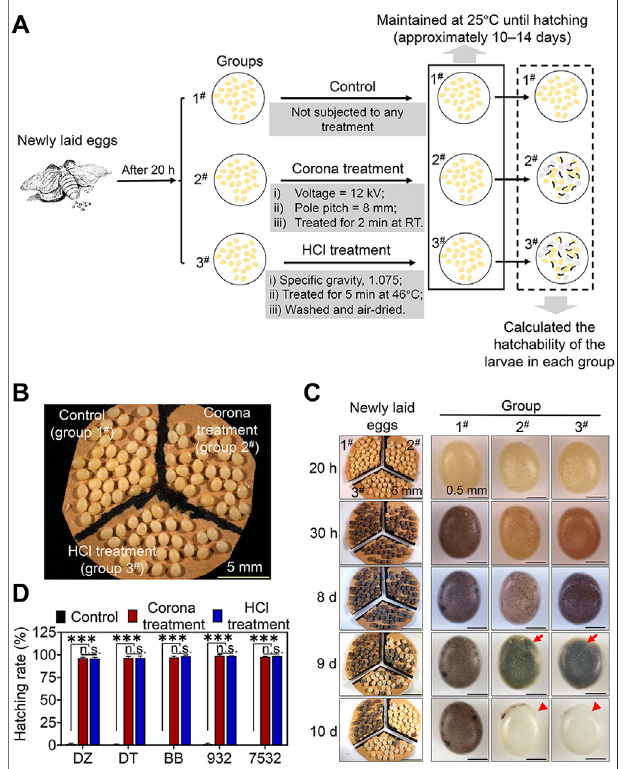
FIGURE 2 | Comparison of the effects of corona and HCl treatments in preventing the diapause of eggs at 20 h after oviposition. (A) Schematic diagramoftheexperimentalprocessoftreatingnewlylaideggsunderdifferent conditions and comparing the larval hatchability. (B) Image of the grouping of DZ eggs at 20 h after oviposition from one brood. (C) Images of the newly laid DZ eggs at different developmental stages from different treatment groups. Red arrows indicate the heads of the larvae developing in the eggs; red triangles indicate the eggshells left by the larvae after hatching. (D) The hatching rates of the larvae from different treatment groups of each strain. Error bars represent one standard deviation ( n = 3; n.s., not signi fi cant; *** p <